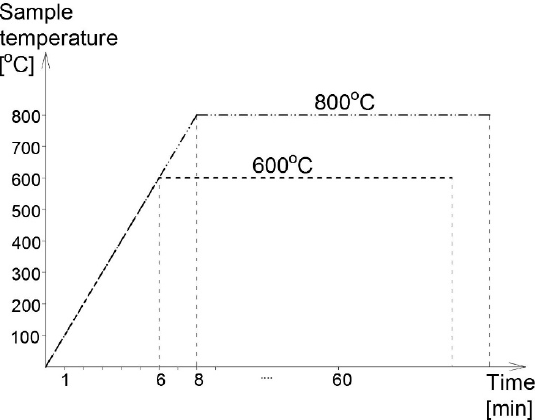
Figure 4. Fire action simulated during research.